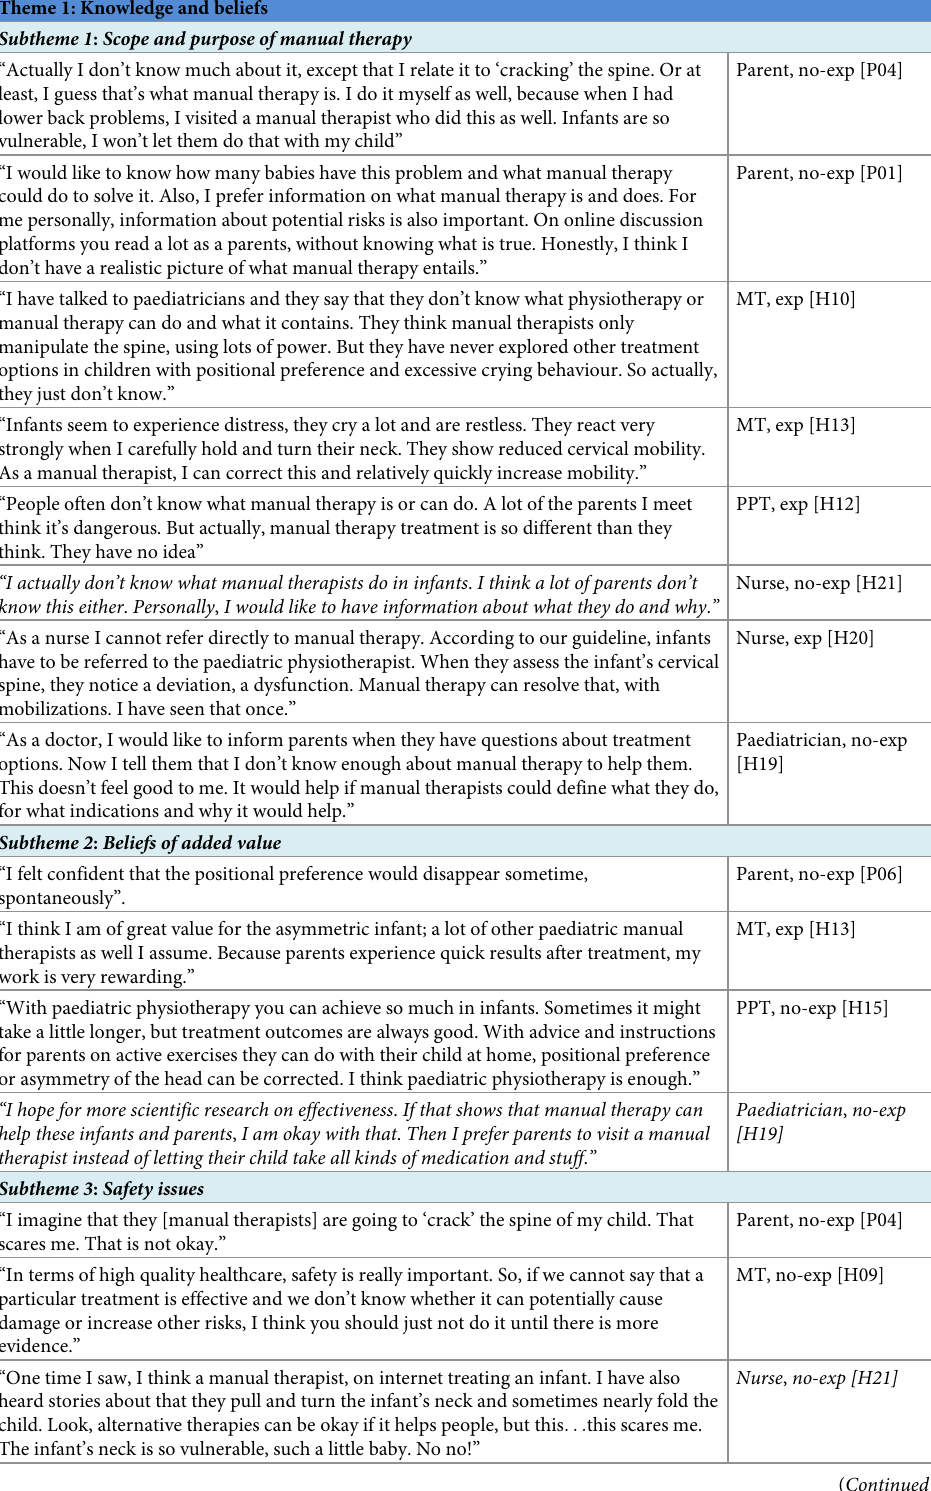
Table 3. Quotations of participants reported per theme and subtheme *